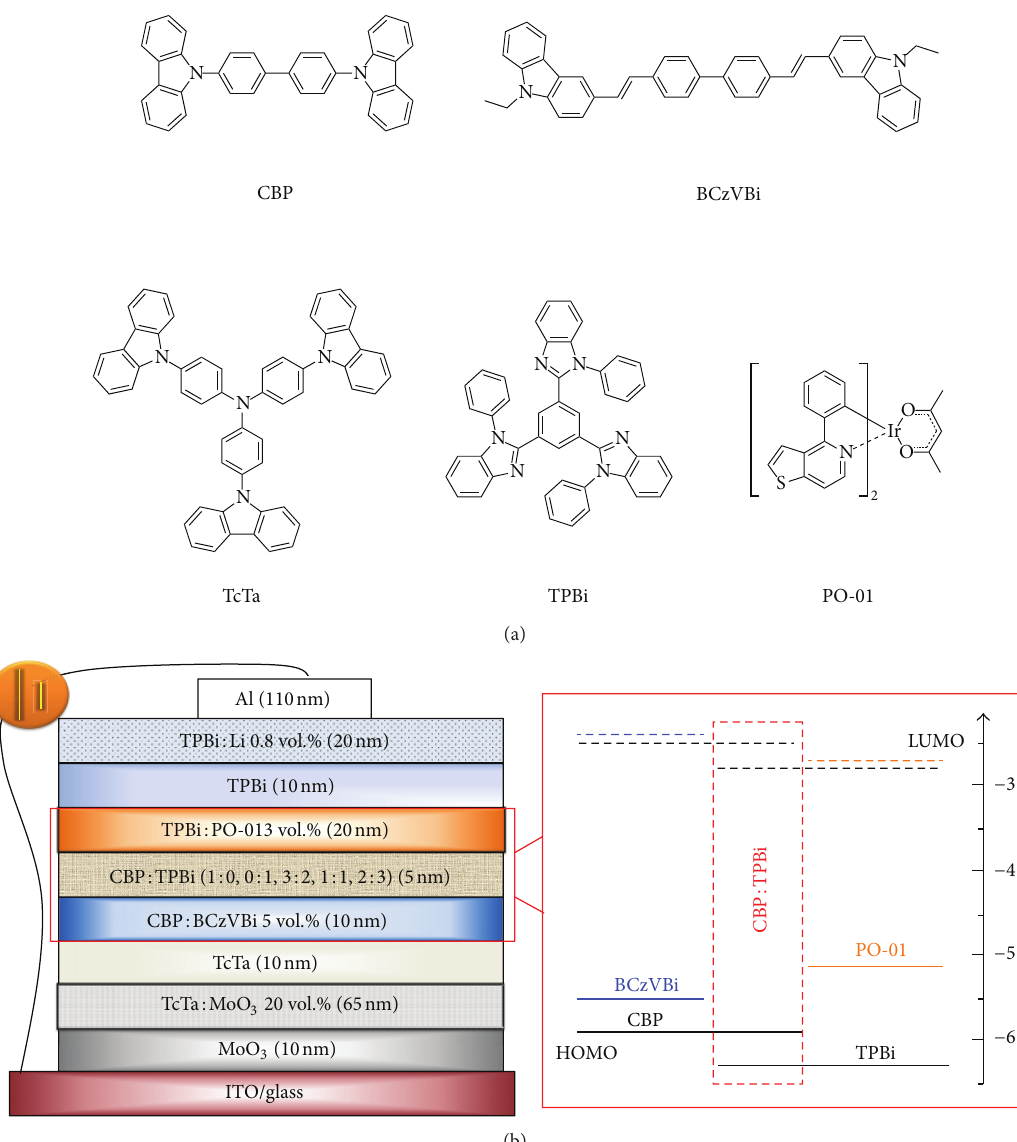
Figure 1: (a) The chemical structures of organic materials, (b) the device structure and the energy level diagram of HOMO (solid lines) and LUMO (dashed lines) levels (eV) of HWOLEDs (Devices A, B, C, D, and E). The red dashed box depicts the “Spacer” composed of different ratios of CBP to